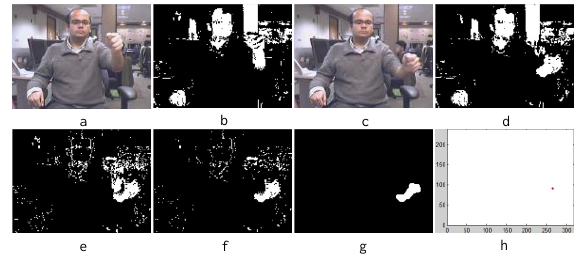
Figure 6. Hand detection of skin-subtraction: a) background frame. b) Skin in background. c) 20 th frame. d) Skin in 20 th frame. e) Exclusive-or of (b) and (d). f) AND (e, NOT (b)). g) De-noise. h) Region center.